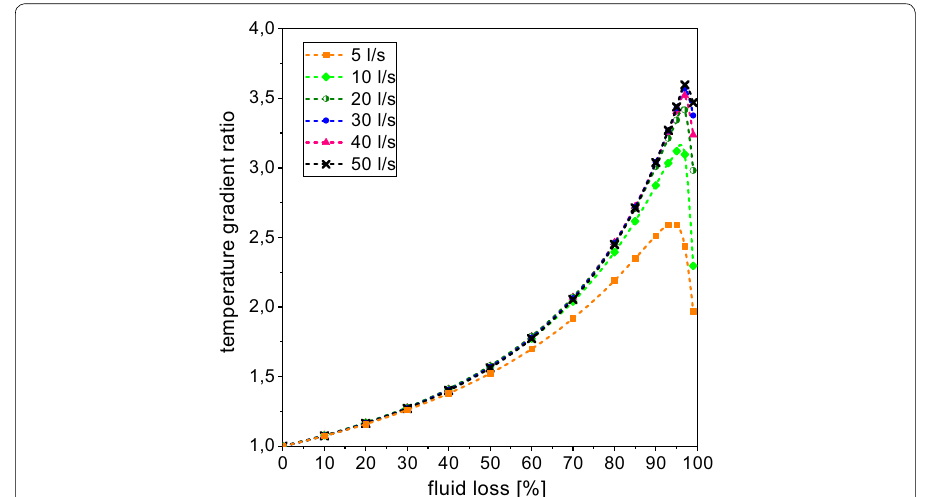
Fig. 7 The ratio of temperature gradient below the fluid loss zone (3.35 km depth) to the gradient above the fluid loss zone versus the percentage of fluid loss (S-shaped SFT profile is